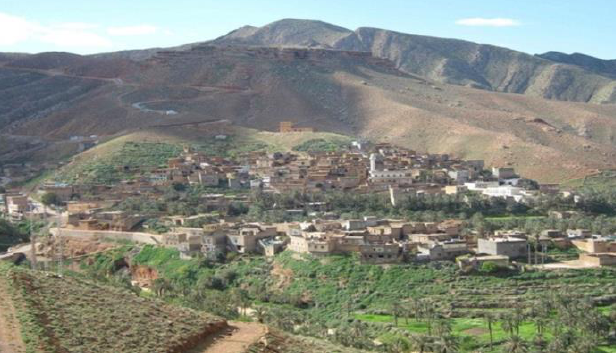
Figure 4. Warka, a typical Berber village. (Authors,